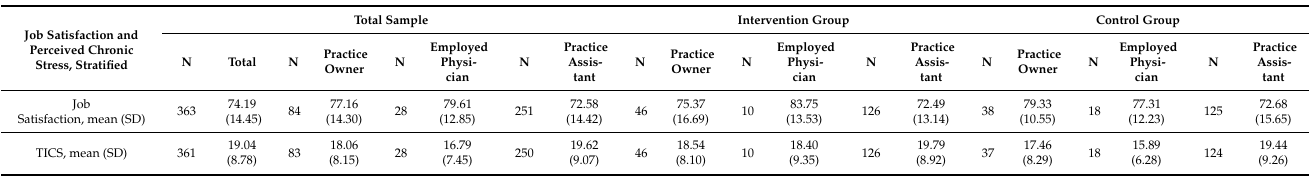
Table A1. Job satisfaction (German COPSOQ, version 2018) and perceived chronic stress: total sample and stratified by profession as well as study